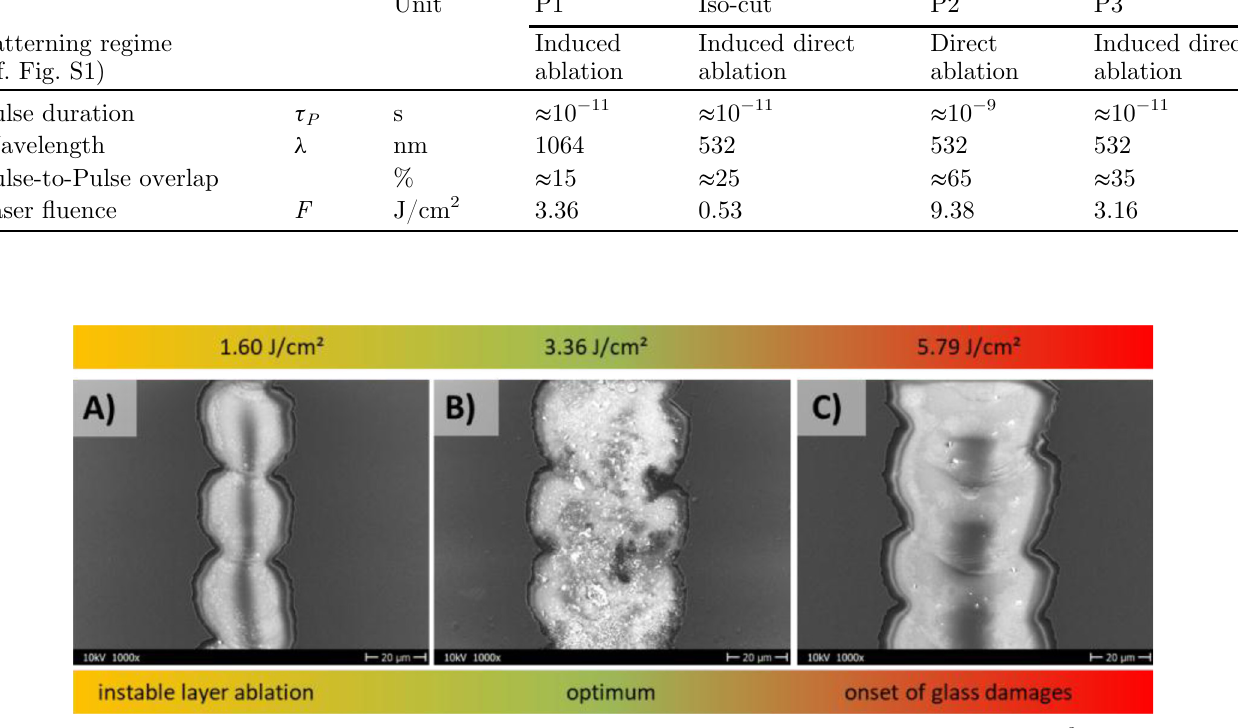
Fig. 3. Comparison of SEM images of P1 scribe lines patterned with three characteristic fl uences: (A) 1.16 J/cm 2 (incomplete layer ablation), (B) 3.36 J/cm 2 (optimal scribe line properties), and (C) 5.79J/cm 2 (onset of glass damages). The color bars indicate the respective patterning regimes and the chosen patterning fl uences. The magni fi cation the images is 1000 (cid:1) , the excitation voltage is 10